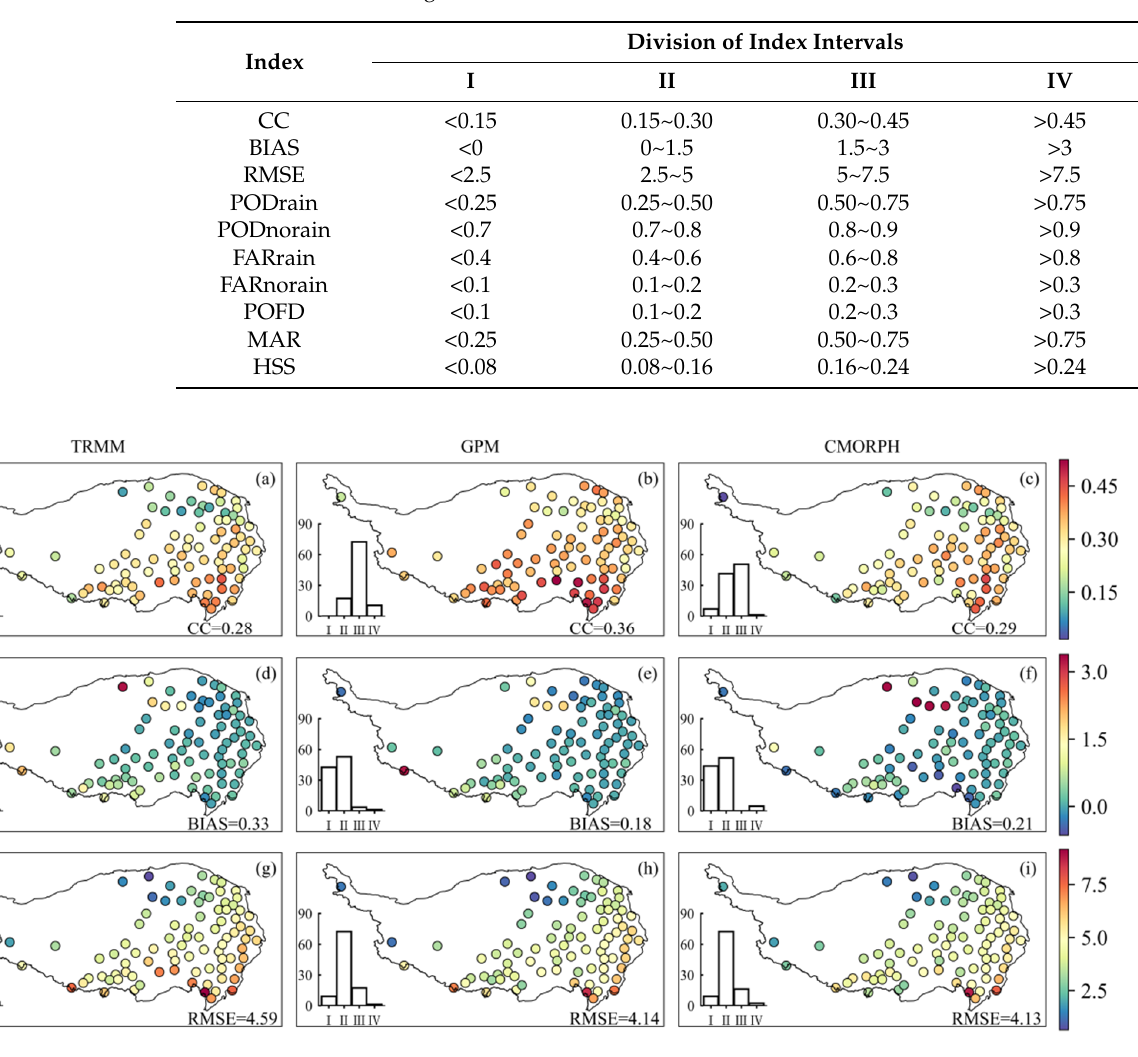
Table 2. The indicted range for each evaluation index interval.